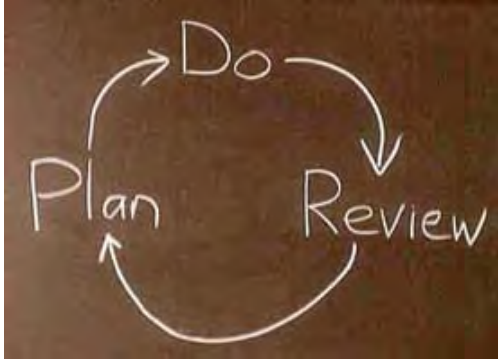
figure 2: Do-Review-Plan: A 3-stage experiential learning cycle (Neill, 2004, online).